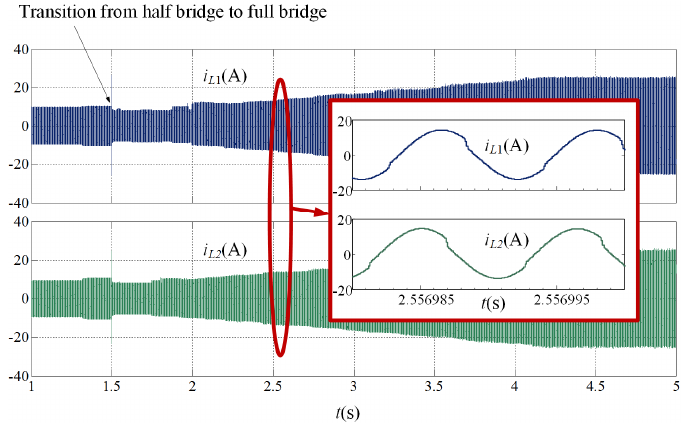
Figure 12. Two channel LLC currents in on-line mode during load transition from 0 to 7 kW load.